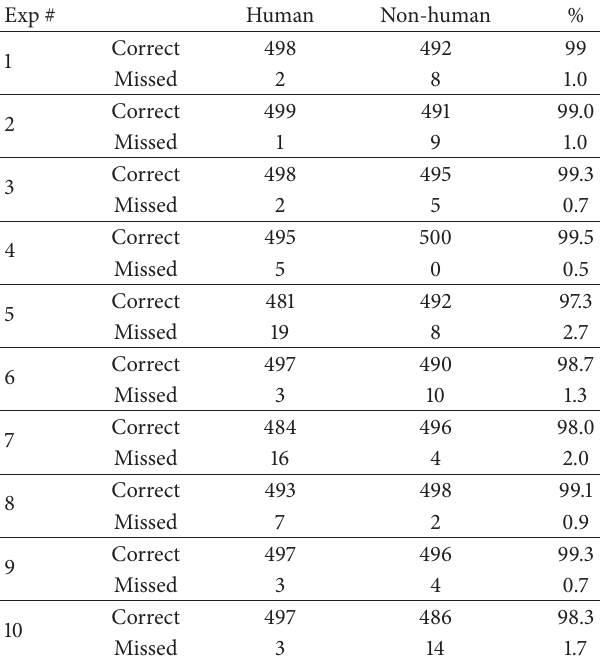
Table 4: Classification results.